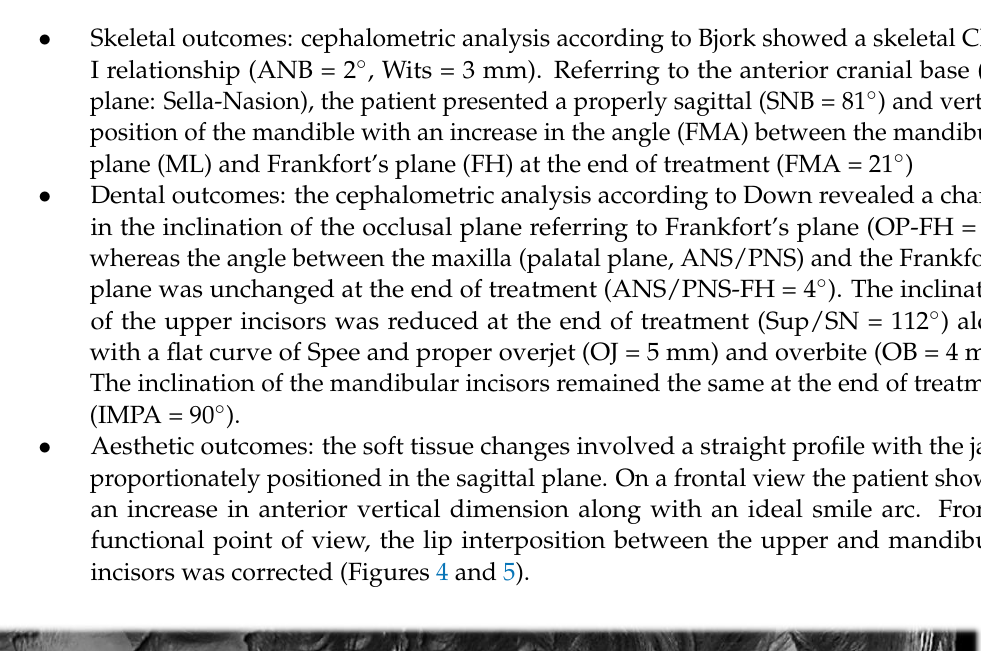
Figure 4. Post-treatment intraoral, extraoral photographs and radiographic examination.